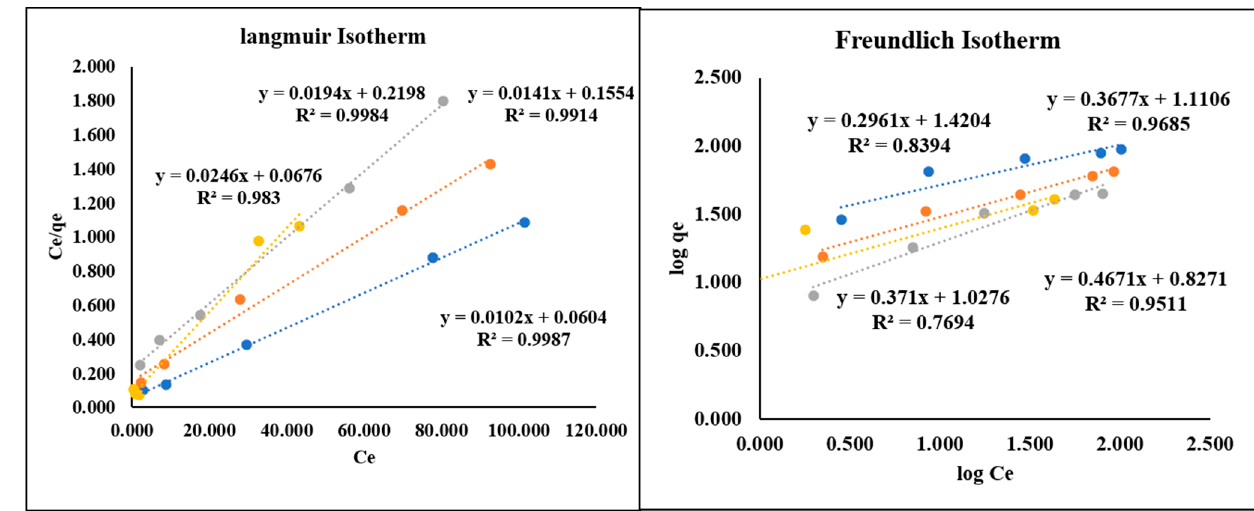
Figure 5. ( a ) Langmuir isotherm plot, ( b ) Freundlich isotherm plot for removal of Cr(VI) using Fe 3 O 4 NPs